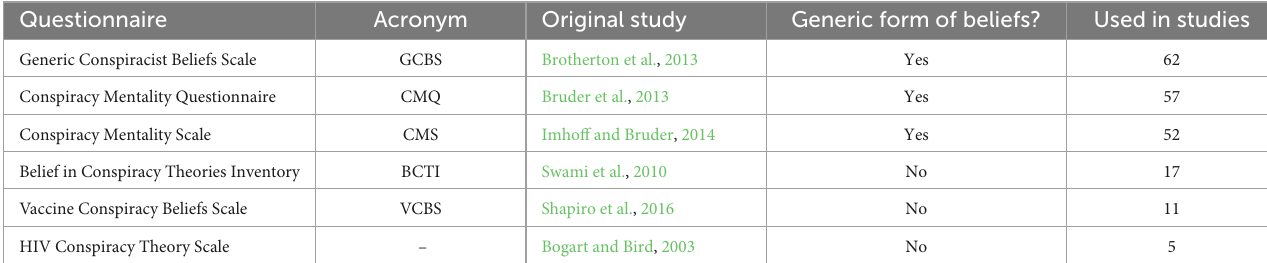
TABLE 2 Questionnaires most used in the studies included in the